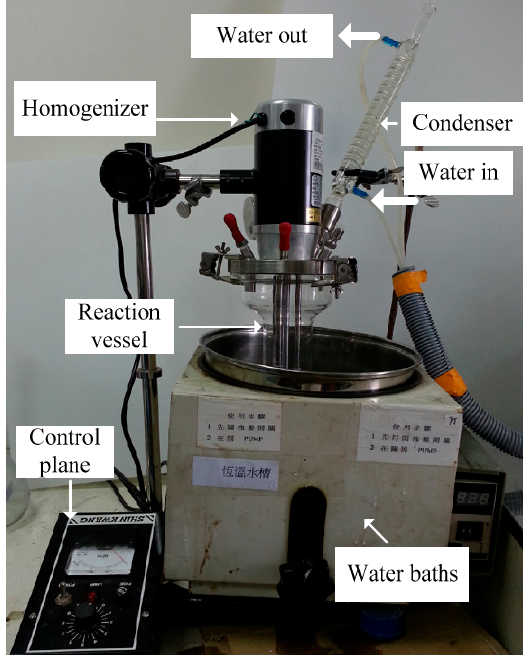
Figure 1. The experimental setup.